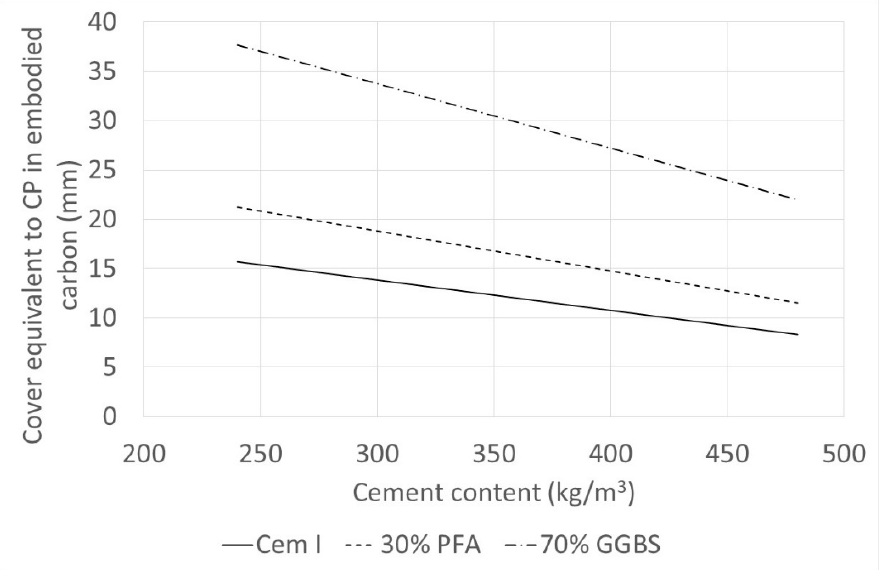
Figure 6. Cover equivalent (in mm) to the embodied carbon of a cathodic protection system.